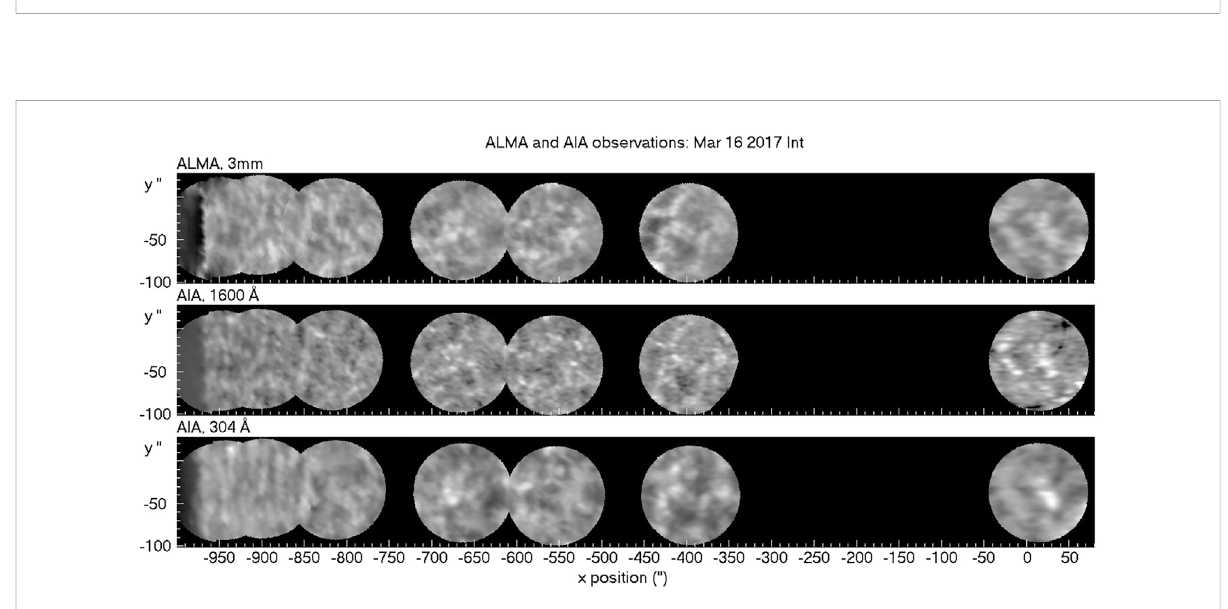
FIGURE 11 ALMAandAIAimagesofthequietSun.Toprow:Compositeofseven3 mmALMAimagesfromthelimb(atleft)tothecenterofthedisc.Second andthirdrows:CompositesofAIA1600and304 ÅimagesforthesametimeintervalsandFOVsastheALMAimages,convolvedwiththeALMAbeam. The photospheric radius is 964.8 ′′ . From Nindos et al., 2018, reproduced with permission ⓒ